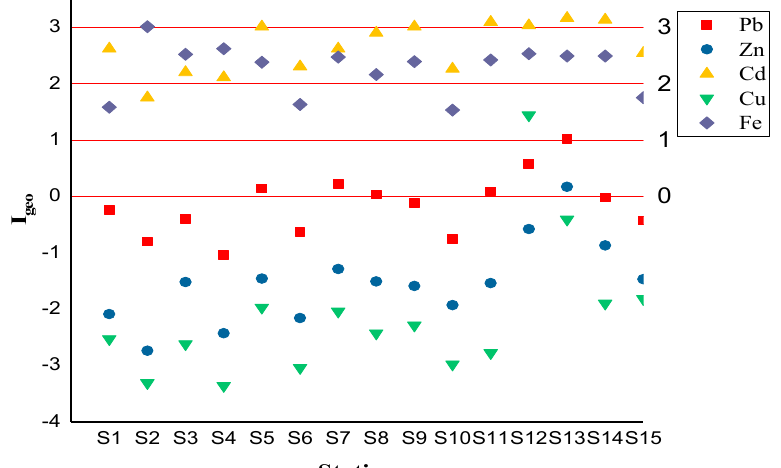
Figure 5. Igeoaccumulation index surface sediment in the Perak River (the reference line at point 0,12,3 represents the different Muller classes). I geo < 0, uncontaminated; 0 < I geo < 1, uncontaminated ‐ to ‐ moderately uncontaminated; 0 < I geo < 2, moderately contaminated; 2 < I geo < 3, moderately ‐ to ‐ heavily contaminated; 3 < I geo < 4, heavily contaminated; 4 < I geo < 5, heavily ‐ to ‐ extremely contaminated; I geo > 5, extremely contaminated.